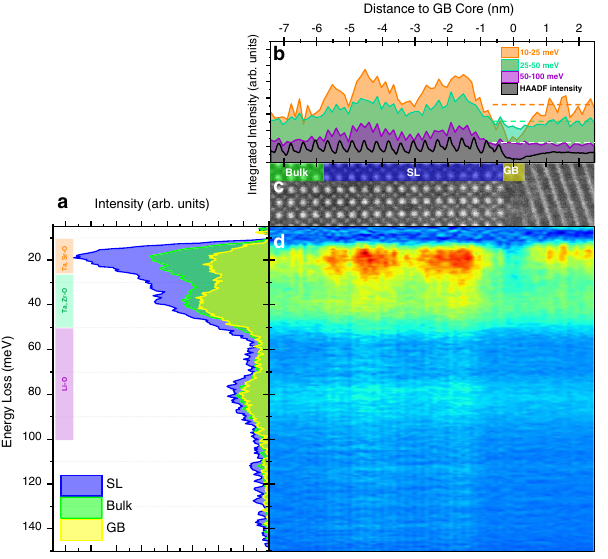
Fig. 5 | Vibrational EELS of (010) faceted and general GBs. a Representative vibrational spectraat the SL, bulk, and GB regions of a (010) faceted GB.Averaged vibrational spectral intensities are higher at the SL region than in the bulk and GB. The colored labeling to the left of the peak denotes the energy ranges over which the signal was averaged and corresponds to speci fi c elemental vibrations with oxygen. b Line pro fi les of the averaged intensities denoted in ( a ) overlaid with a vertically integrated HAADF line pro fi le. While all intensity-averaged curves show modulations in the SL region, only the intensity of the Ta-, Sr-O vibrations shows a large dip at the GB. The B-site vibrational intensity (Ta-, Zr-O) shows a smaller dip whilethevibrationalEELSsignalcorrespondingtoLi-Ovibrationsshowsnochange frombulkattheGB. c HAADFimagecorrespondingtotheregionthe(010)faceted GB spectra were acquired. d Contour plot of vertically-integrated spectral slices